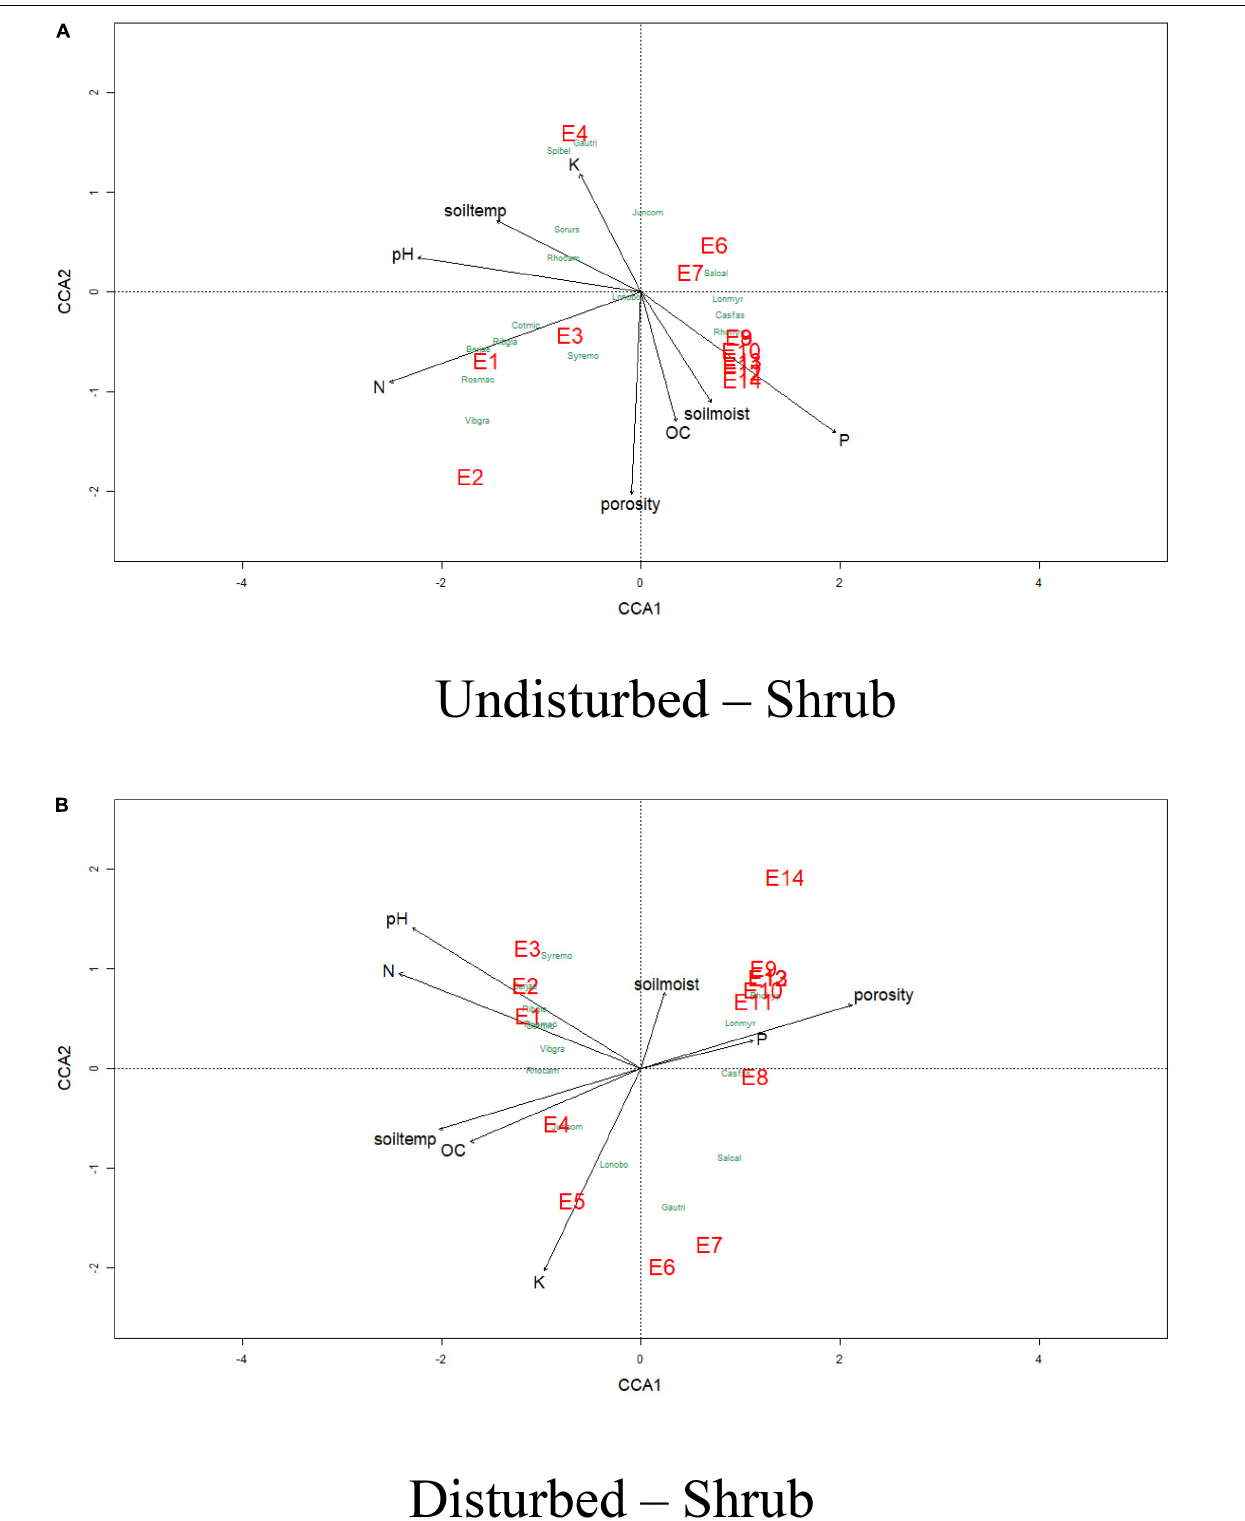
Frontiers in Ecology and Evolution |